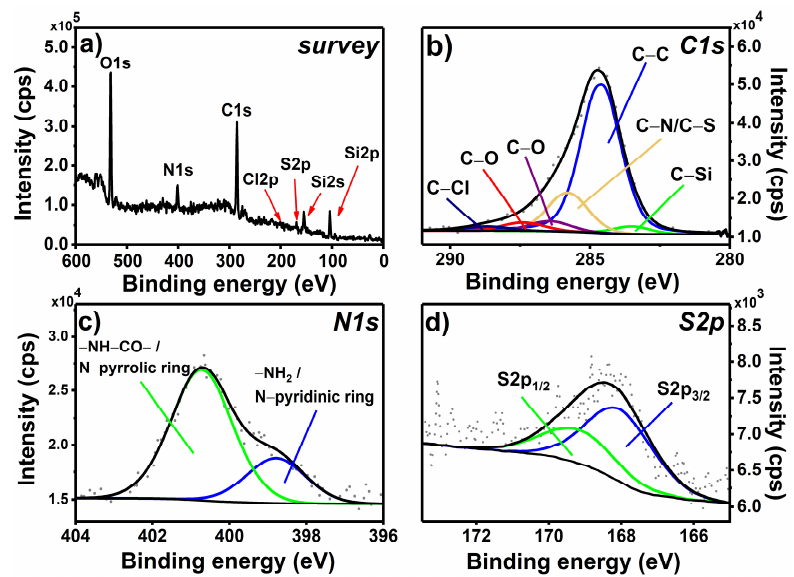
Figure 3. XPS survey spectrum ( a ) and high-resolution spectra of C1s ( b ), N1s ( c ), and S2p ( d ) regions registered for the MIX_TC_APTES@glass monolayer.